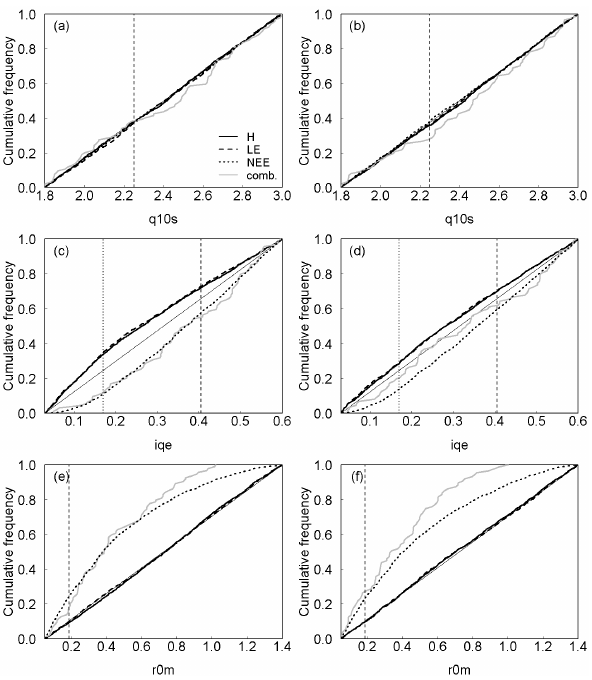
Fig. 5. Cumulative likelihood distributions for the model param- eters q10s, Q 10 for stem respiration [ − ], (a) and (b) , iqe, quan- Figure 5. Cumulative likelihood distributions for the model parameters q10s ( Q 10 for stem 3 tum efficiency [ − ], (c) and (d) , and r0m, microbe basal resp. rate respiration [-], a and b), iqe (quantum efficiency [-], c and d) and r0m (microbe basal resp. 4 at 0 ◦ C [µmolm − 2 s − 1 ], (e) and (f) , for the 10% best parameter rate at 0°C [µmol m -2 s -1 ], e and f) for the 10% best parameter sets for the single-objective and 5 sets for the single-objective and combined coefficients of efficiency combined coefficients of efficiency (left column: IOP-1, right column: IOP-2). The thin black 6 (left column: IOP-1, right column: IOP-2). The thin black diago- diagonal represents a uniform parameter distribution. In (a), (b), (e) and (f) the dashed vertical 7 nal represents a uniform parameter distribution. In (a), (b), (e) and line depicts the reference parameter for the Waldstein-Weidenbrunnen site. In (c) and (d) the 8 (f) the dashed vertical line depicts the reference parameter for the dashed vertical line shows the original ACASA parameter whereas the dotted vertical line 9 Waldstein-Weidenbrunnen site. In (c) and (d) the dashed vertical depicts the reference value of the PSN6 model for our site. 10 line shows the original ACASA parameter whereas the dotted verti- cal line depicts the reference value of the PSN6 model for our site.